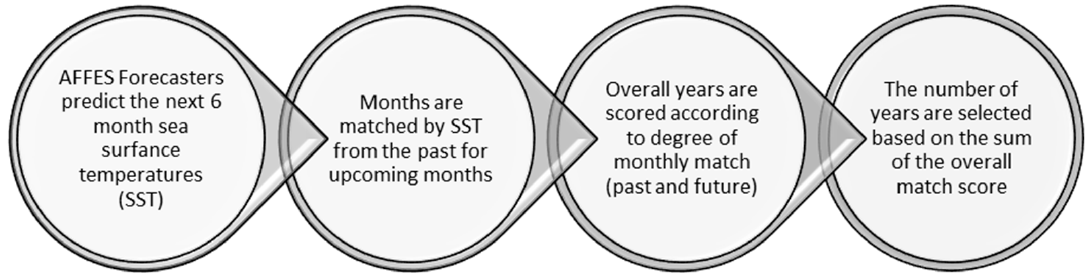
Figure 4. The steps in selecting historical analogue years for the long-term forecast.